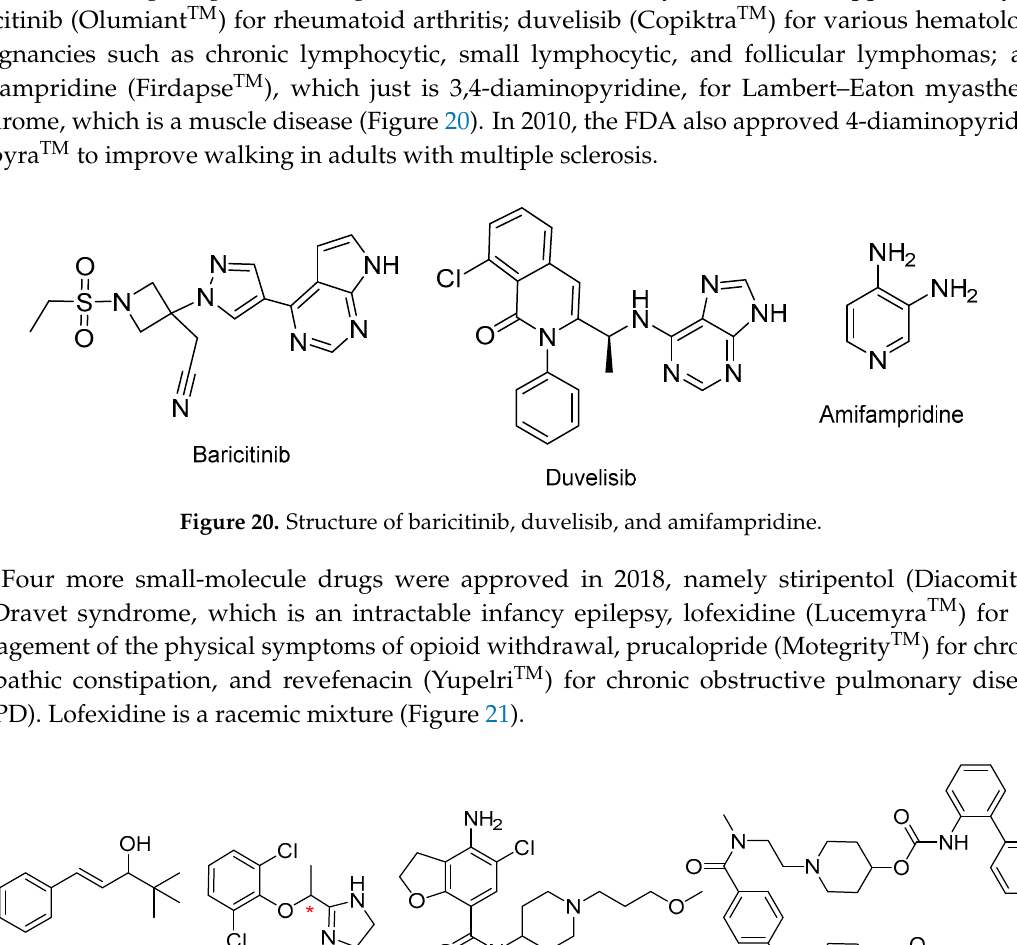
Figure 19. Structure of drugs for the treatment of acute myeloid leukemia.